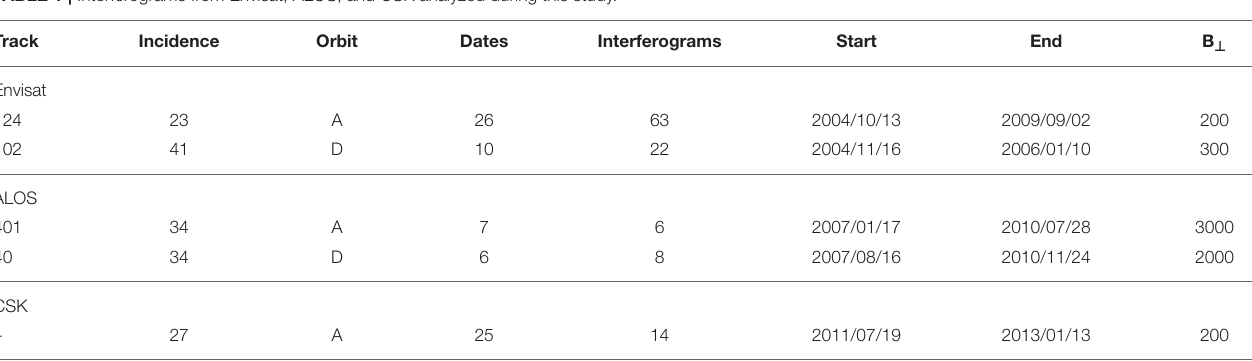
For each track (‘path’ in ALOS), we list left to right: Incidence angle (degrees), orbit direction (A = Ascending, D = Descending), the number of SAR acquisitions processed, number interferograms processed, the most recent and oldest dates used in this study, finally the maximum perpendicular baseline ( B ⊥ ) used in meters. Note that CSK data does not have track